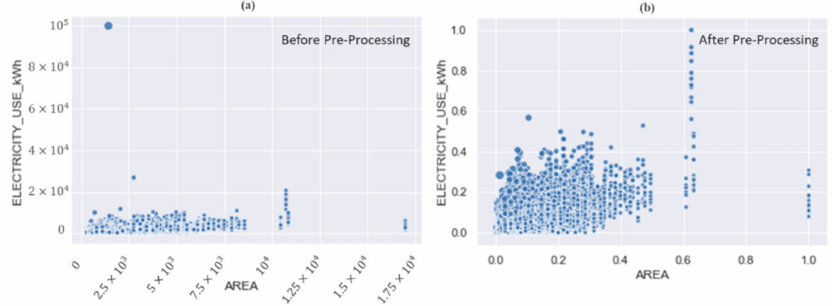
Figure 2. A comparison of the smart sensor data distributions ( a ) before and ( b ) after the pre-processing